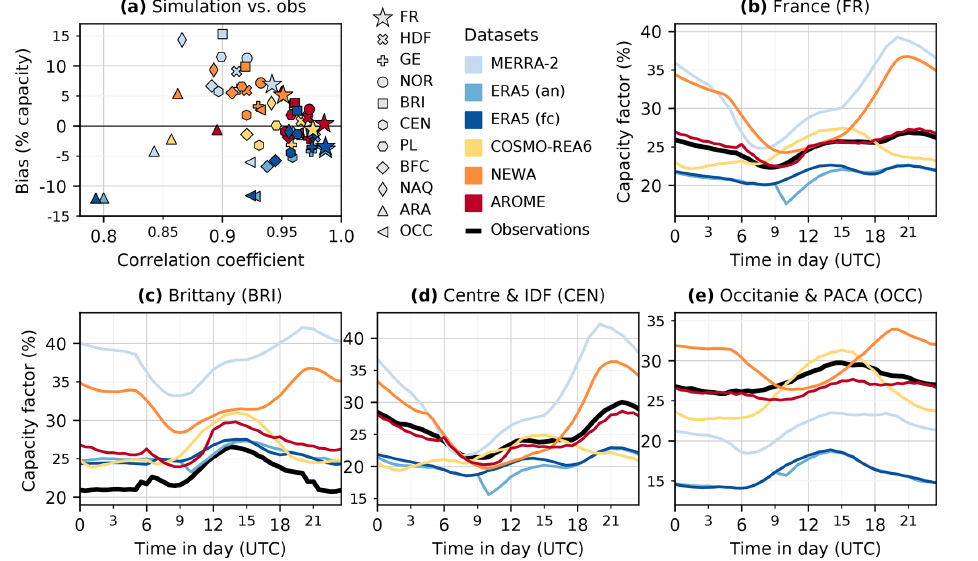
Figure 4. Comparison of modelled and measured wind-power production for France in 2015. (a) For each region (identified by marker style) and each model (identified by marker colour): bias in percent of the installed capacity (model – observation, on the y -axis) versus correlation coefficient (on the x -axis) of the 30min wind-power time series. See region map in Fig. 2. (b–e) Average diurnal cycles of the observed (in black) and modelled (in colours) wind-power capacity factors for the whole France (b) , Brittany (c) , Centre summed with Ile-de-France (d) and Occitanie summed with PACA (e) .